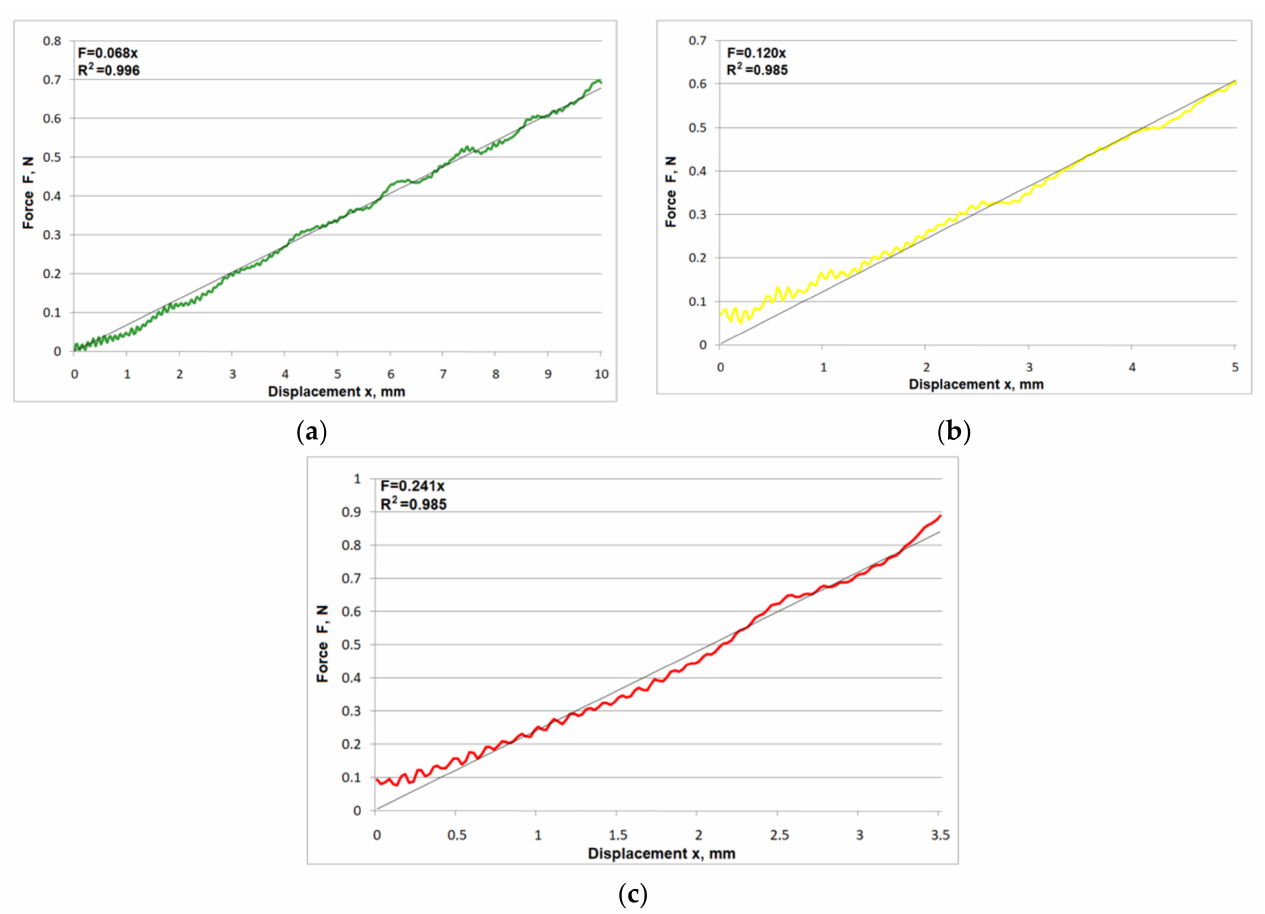
Figure 5. Sample F(x) characteristics for all cutting elements for the following